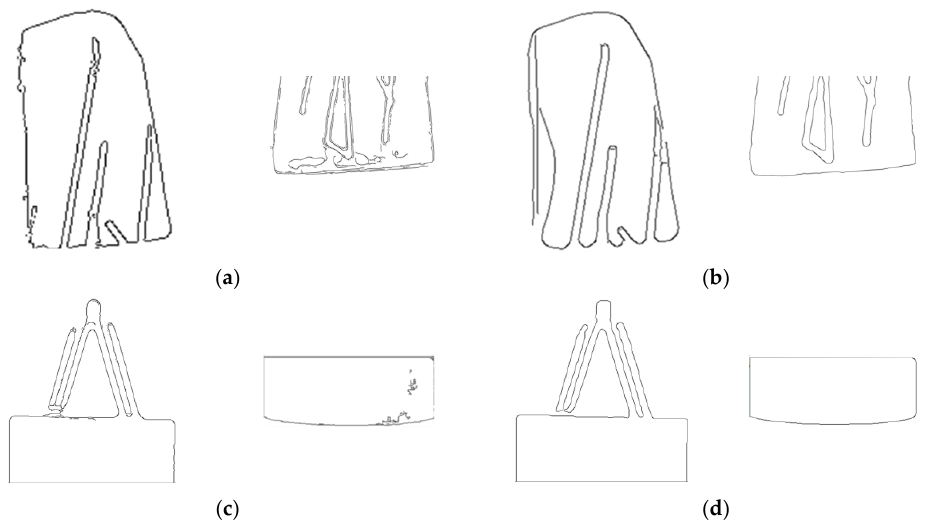
Figure 19. Comparison of edge detection results of different methods. ( a ) Edge detection of the obstacle 1 by traditional Canny algorithm. ( b ) Edge detection of the obstacle 1 by adaptive threshold algorithm of this paper. ( c ) Edge detection of the obstacle 2 by traditional Canny algorithm. ( d ) Edge detection of the obstacle 2 by adaptive threshold algorithm of this paper.